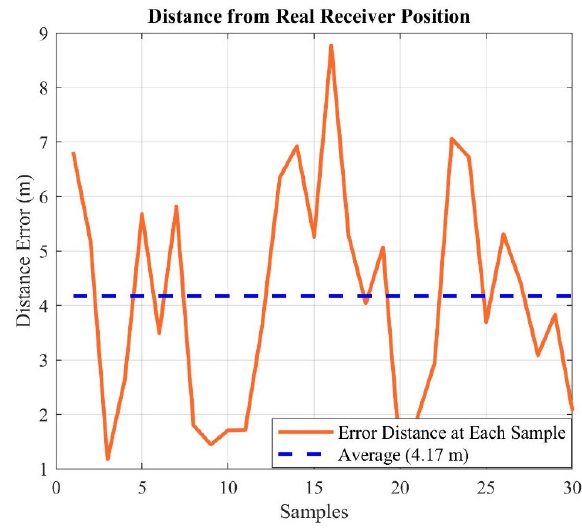
Figure 20. Deviation from the real position for each of 30 points. Under non-line-of-sight conditions in the experiments, while estimated position error increases, it is still possible to achieve sub-meter accuracy. To quantify the increased error amount, one can compare the radius of the 50% CEP circles in Figures 15a and 19a. The radius of the 50% CEP is higher in Experiment 2. Additionally, when CNR values in Figure 17 are compared with those in Figure 13, we can conclude that the non-line-of-sight condi- tion reduces the CNR. In the proposed system, variable attenuators are used to compensate for the non-line-of-sight conditions. To adjust, we can easily set the attenuation level, the retransmitted GPS power levels, and adjust the CNR levels so that the receivers can receive almost equal signal levels from each direction and each satellite. That is the reason why the attenuation level of Repeater 2 is set to a lower level in Experiment 2.